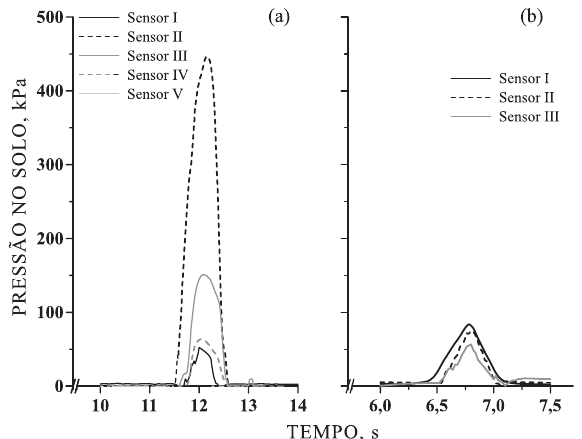
Figura 2. Medidas de pressão no solo em função do tempo de passagem da máquina sobre a área. (a) sensores instalados para as medições sob o pneu do trator e (b) sensores instalados para as medições sob a linha da